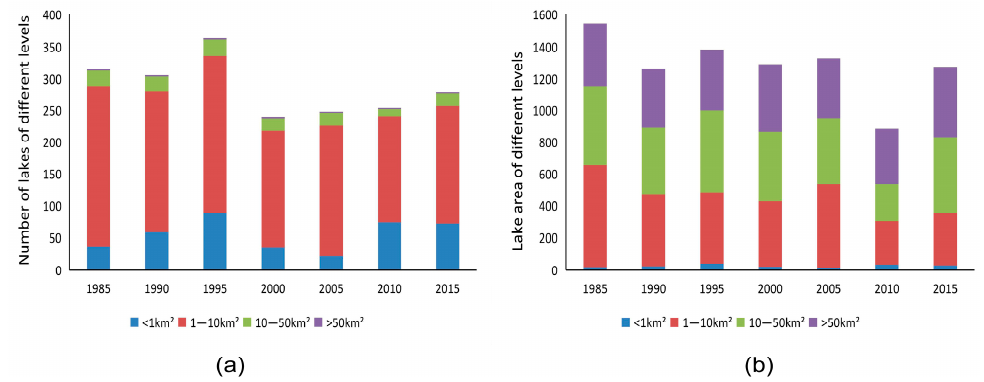
Figure 2. ( a ) In 1985, 1990, 1995, 2000, 2005, 2010, 2015, the number of lakes in different area ranges (less than 1 km 2 , 1 to 10 km 2 , 10 to 50 km 2 and greater than 50 km 2 ); ( b ) The area of lakes in different ranges.